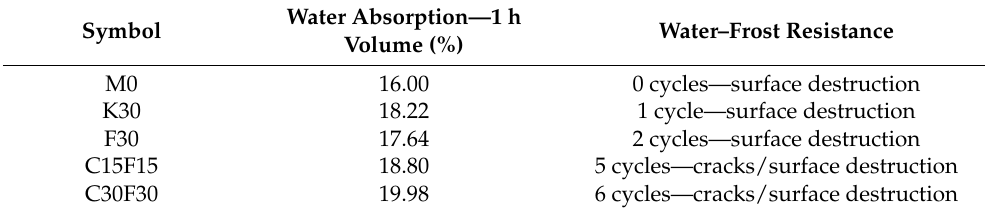
Table 3. The amount of water absorbed and water – frost resistance of tested lime mortars.